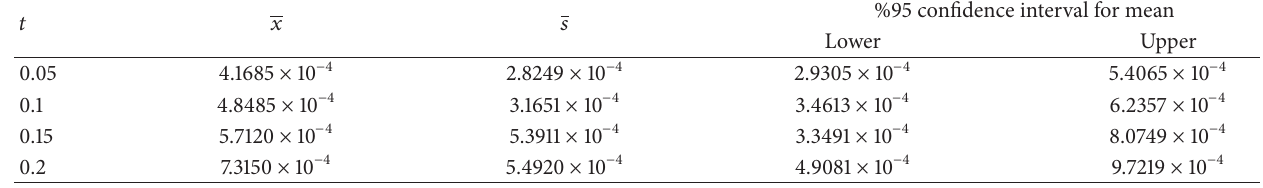
Table 4: Mean, standard deviation, and confidence interval for numerical solution mean ( 𝑇 = 0.25 , 𝐻 = 2/3